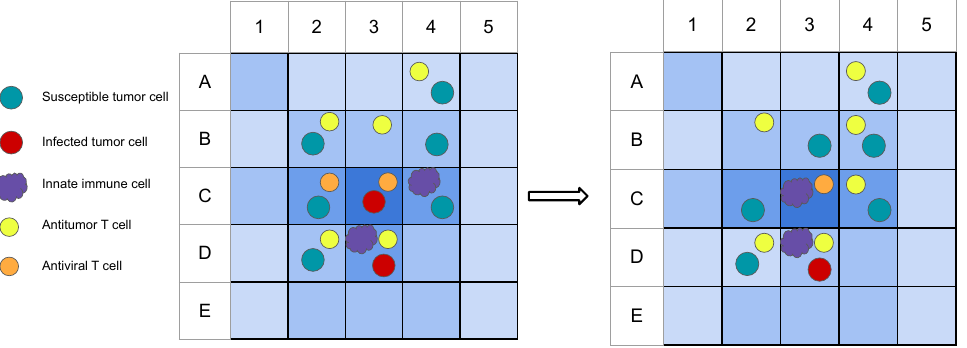
Figure 1. An example of a two-dimensional cross-section of the ABM before ( left ) and after ( right ) a time step τ . The blue shades in the background indicate the viral concentration levels at each site, with darker shades representing higher viral concentrations. In this example, the T cell in A4 replicates and places a daughter T cell in B4, the antitumor T cell in B2 kills the susceptible tumor cell, the T cell in B3 moves to C4, the tumor cell in B4 replicates and places a daughter cell in B3, the T cell in C2 dies naturally, the antiviral T cell in C3 kills the infected cell, the innate immune cell in C4 moves to C3, the viral concentration in D2 decreases due to T cell consumption, and the viral concentration in D3 decreases due to innate immune cell